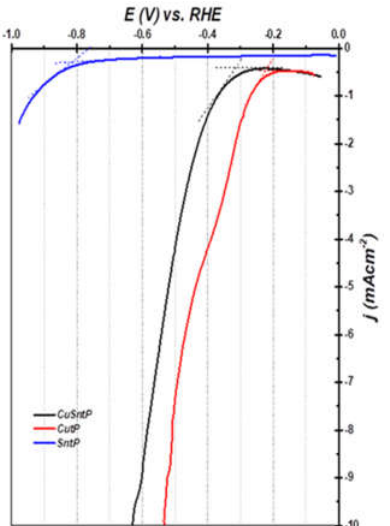
Figure 9. HER polarization curves of MOF catalysts in 0.1 M KOH.